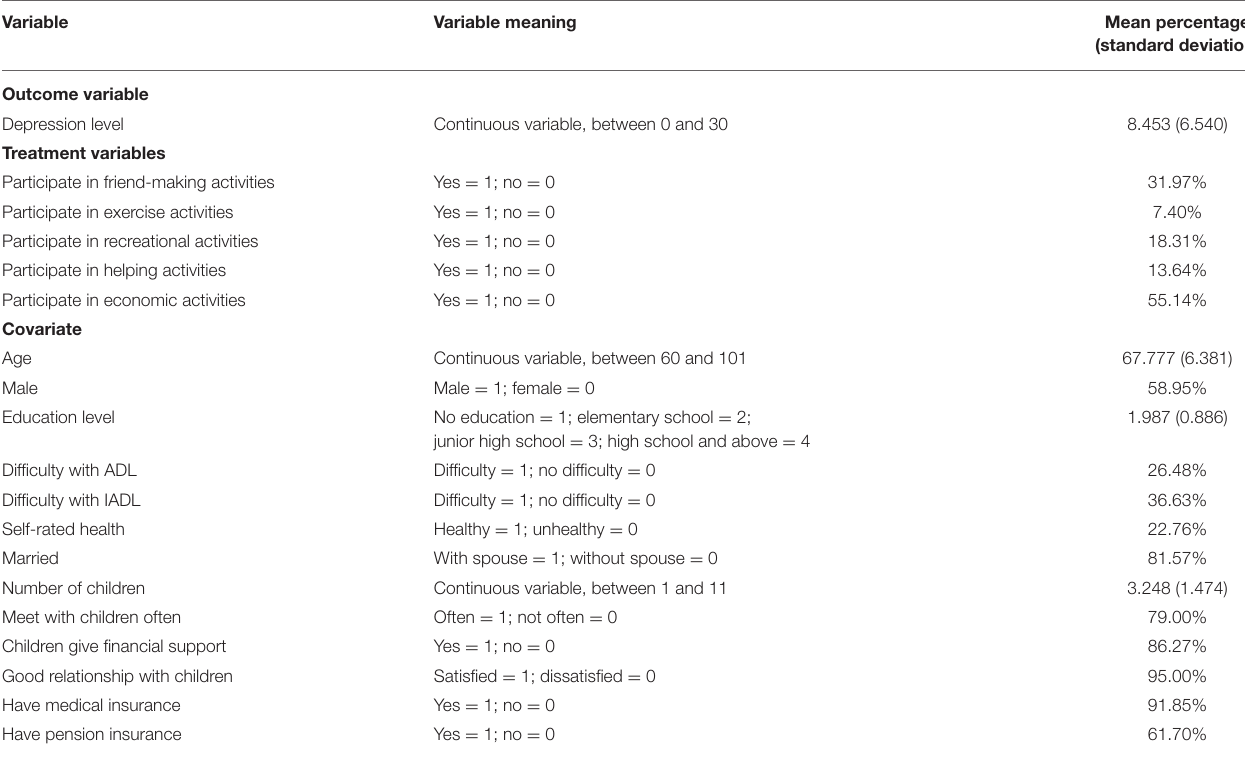
TABLE 2 | Variable definition and sample description.